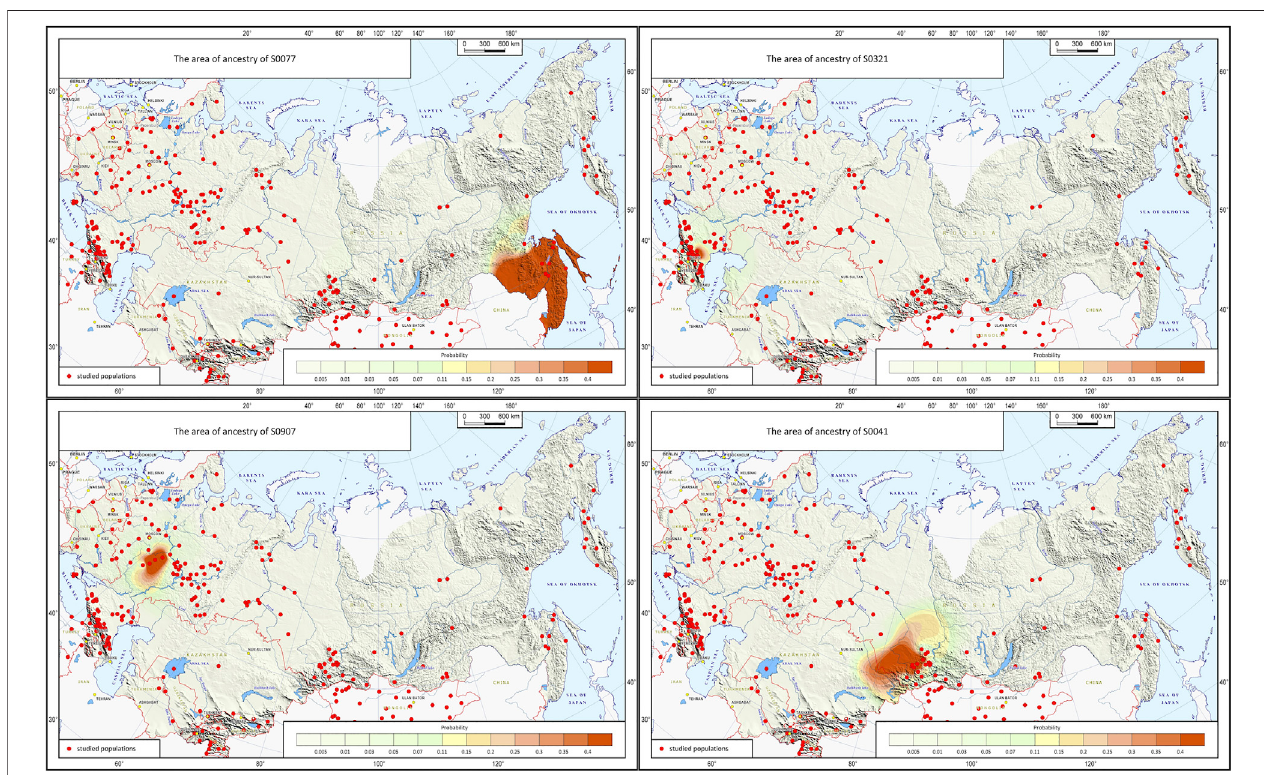
FIGURE 4 | Example of the map generated by the Homeland